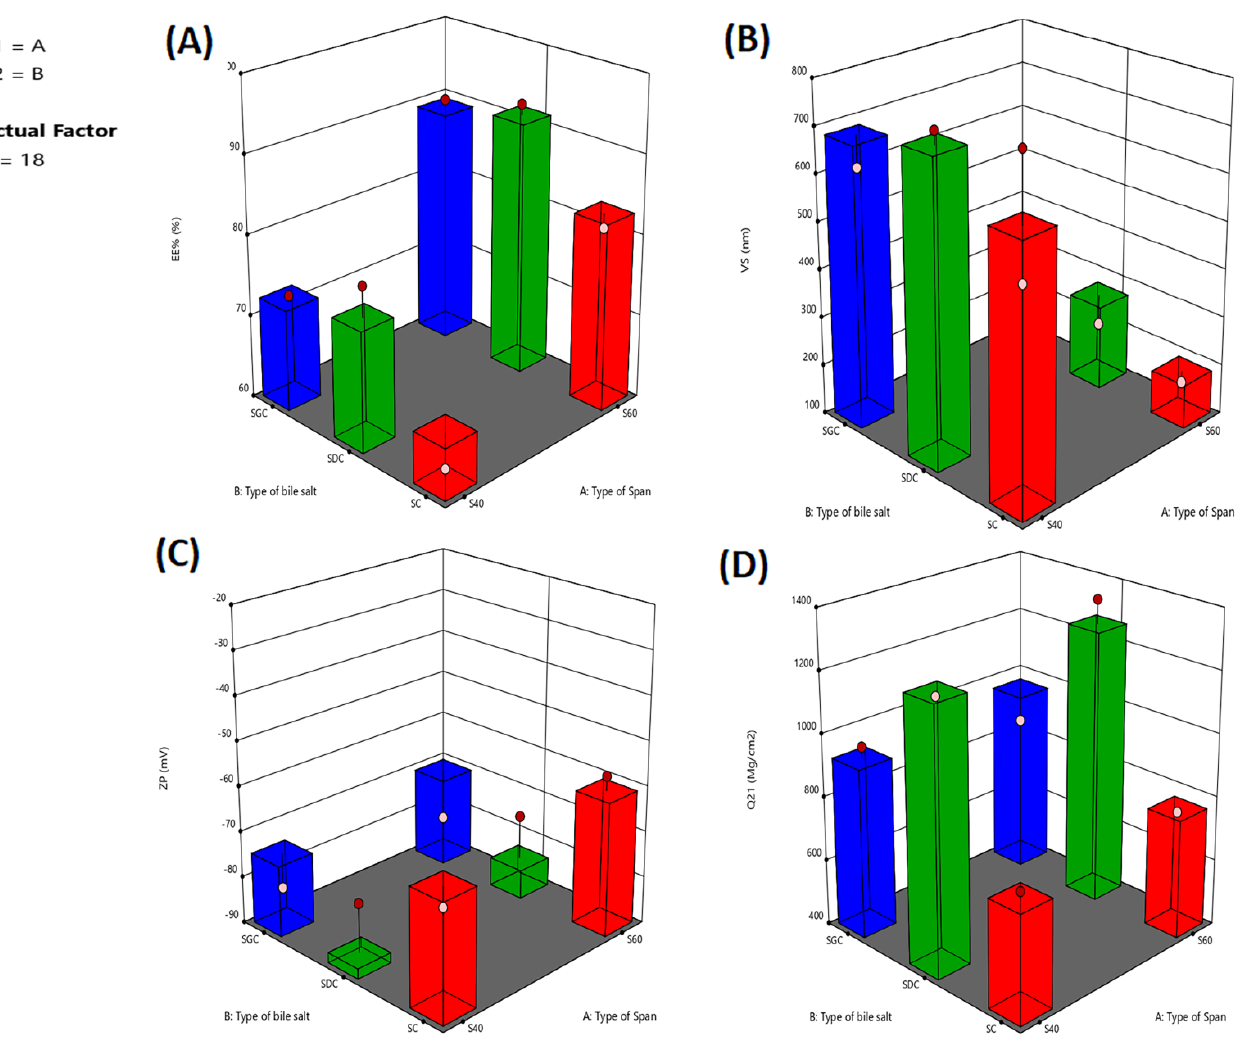
Figure 3. 3D response surface plots showing the influence of span type, bile salt type and bile salt amount of DNa-BSVCs on different responses of EE: entrapment efficiency ( A ); VS: vesicle size ( B ); ZP: zeta potential ( C ); Q21 h: cumulative amount of drug permeated ( D ).